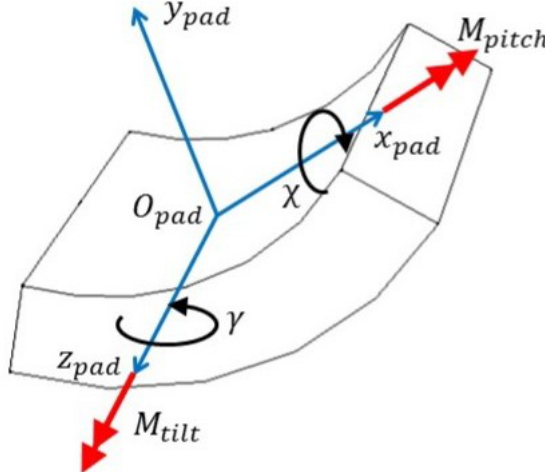
Figure 5. Angles and forces acting on the tilting